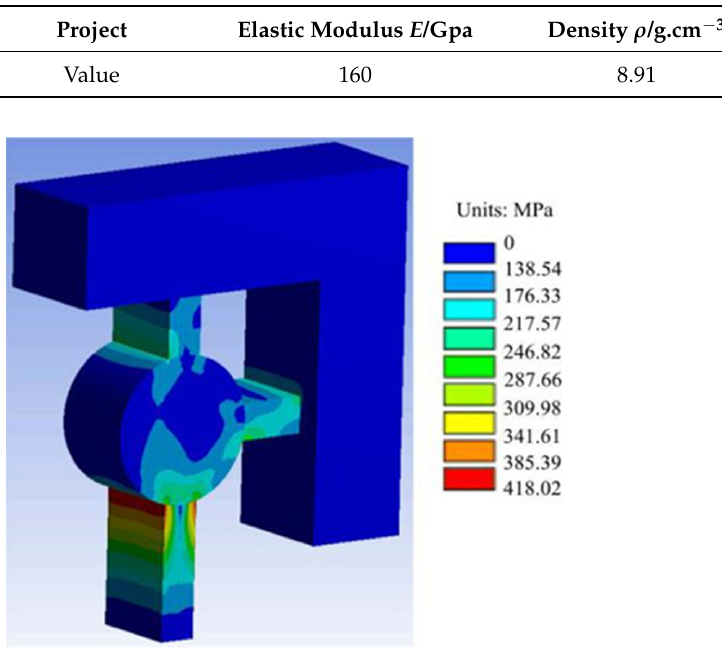
Figure 7. Stress nephogram. Table 1. Material parameters of the shear pin.